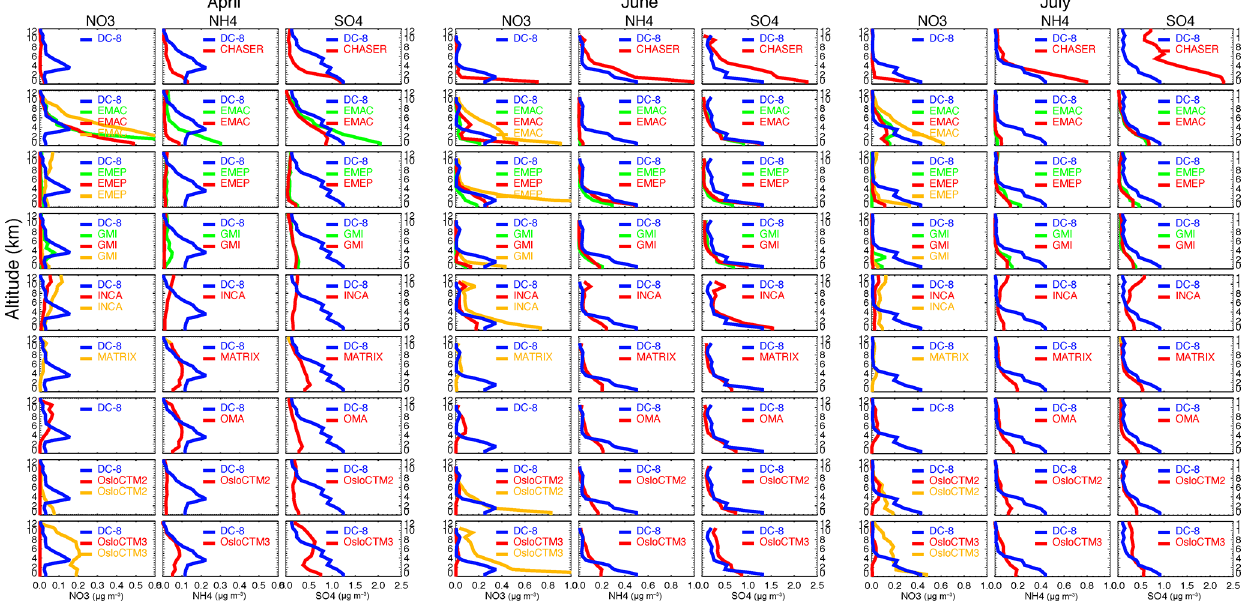
Figure 5. Vertical profile comparison between ARCTAS aircraft measurements and AeroCom model simulations. Note that ARCTAS AMS measurements give fine-mode aerosols. Model profiles are shown in green (fine-mode aerosol analyzed with daily output), red (fine-mode aerosol with monthly output), and orange (total NO − µgm − 3